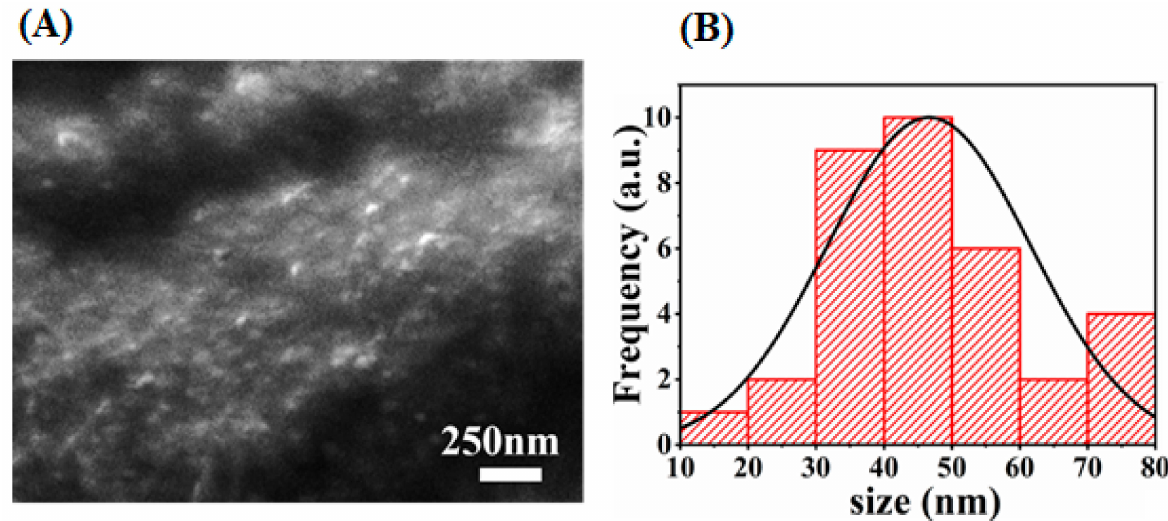
Figure 10. SEM image of AgNPs with 250 nm scale bar ( A ), and their corresponding size distribution histogram ( B